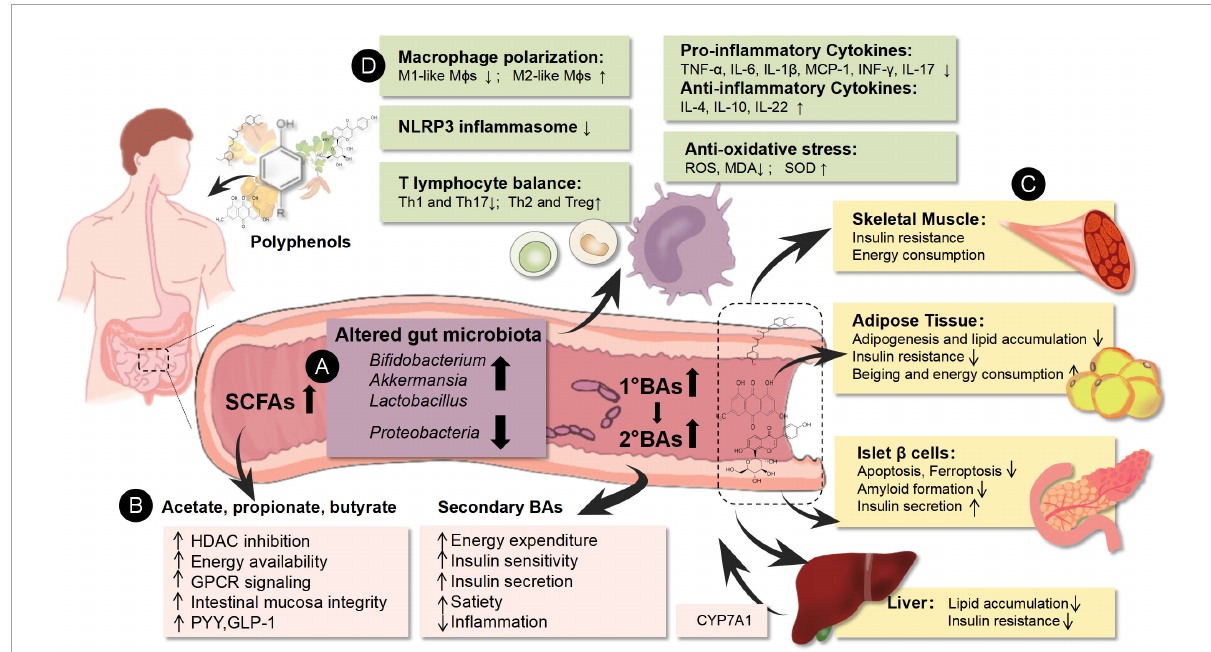
FIGURE1 Environmental factors could affect the epigenetics of immune cells to generate tissue inflammatory states and induce metabolic disorders. The pathogenesis of obesity and T2DM is associated with gut microbial disturbance, metabolic disorder, and immune imbalance. Based on network mechanisms, natural polyphenols showed multiple targets in the treatment of obesity and T2DM, including enrichment of beneficial gut microbiota ( Bifidobacterium, Akkermansia, and Lactobacillus ) and decrease of the abundance of harmful gut microbiota ( Proteobacteria ), increase of gut microbiota-derived metabolites (SCFAs, BAs), as well as regulation of the host glucolipid metabolism of pancreatic islets, adipose tissue, liver, and skeletal muscle. Meanwhile, the mechanisms of natural polyphenols are also related to immunity rebalance through polarization of M φ s and the ratio of T lymphocyte subtypes. They could down-regulate the pro-inflammatory immune cells (M1-like M φ s, Th1, and Th17 cells) and their related cytokines (TNF- α , IL-6, IL-1 β , MCP-1, INF- γ , and IL-17) as well as up-regulate the anti-inflammatory immune cells (M2-like M φ s, Th2, and Treg cells) and their related cytokines (IL-4, IL-10, and IL-22). Besides, their antioxidant effects contributed to immunoregulation. ↑ means up-regulation after natural polyphenols intervention; ↓ means the down-regulation after natural polyphenols intervention. (A) Represents the purple area; (B) represents the pink area; (C) represents the yellow area; (D) represents the green